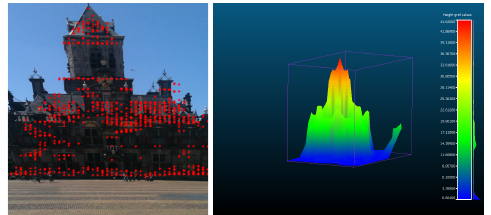
Figure 4: (a) Iphone image is registered with projected LIDAR points, (b) Generated 3D mesh model of the interest building.